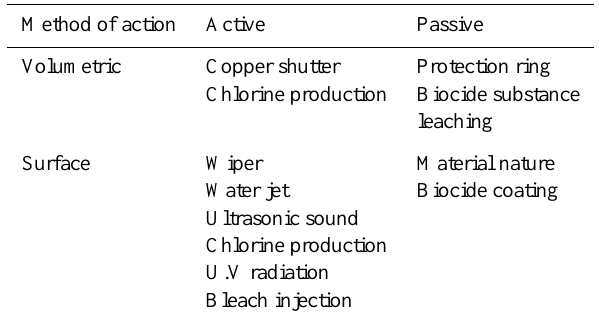
Fig 3 : Drift of an unprotected fluorometer due to biofouling